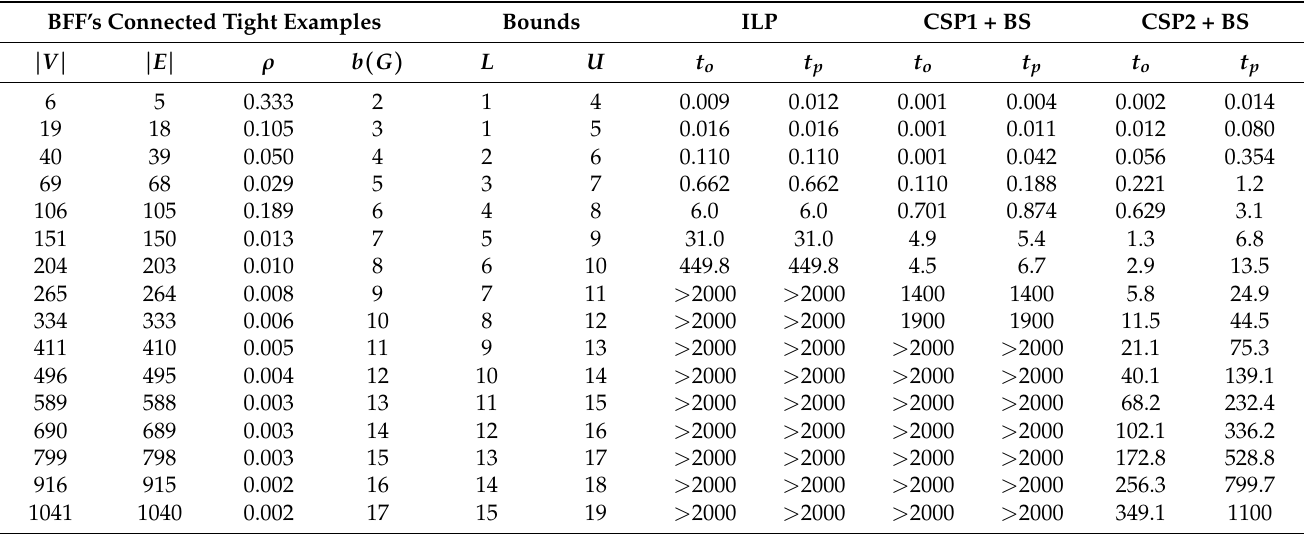
Table 2. Running time of the implemented mathematical formulations over a set of connected tight examples for the BFF